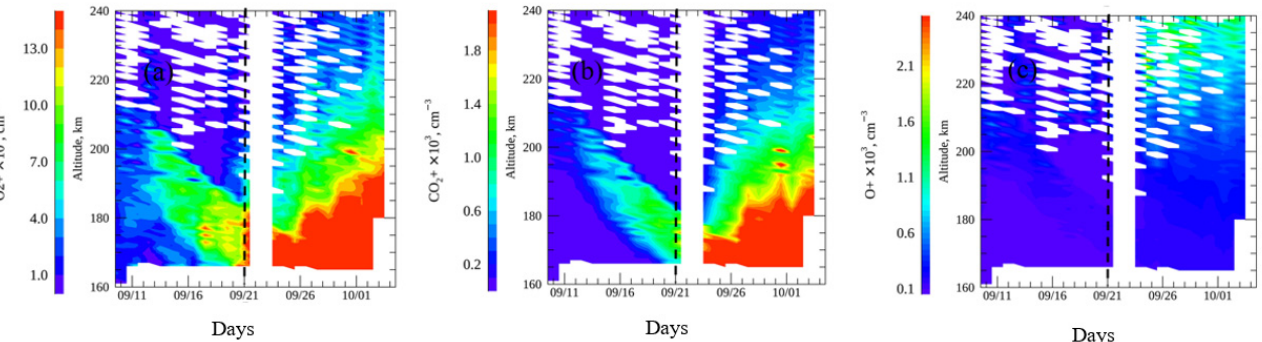
Figure 2. Ion species distribution from 9 September to 4 October 2016, at altitudes of 160–240 km and SZAs of 75–130°: ( a ) O 2+ , ( b ) CO 2+ , and ( c ) O + . The vertical black line on 21 September 2016 indicates the storm onset. The blank regions represent missing NGIMS data from all of 21 September.